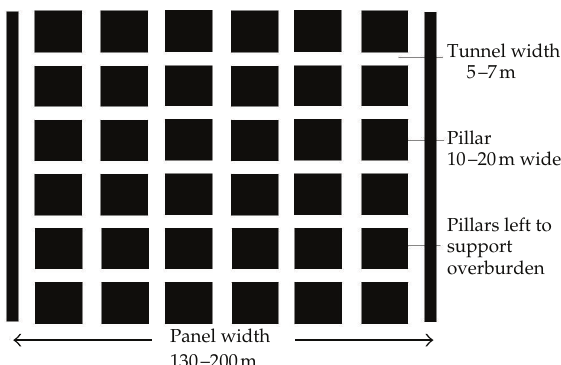
Figure 1: A mining panel showing the pillars before pillar extraction. Reproduced with permission from N. van der